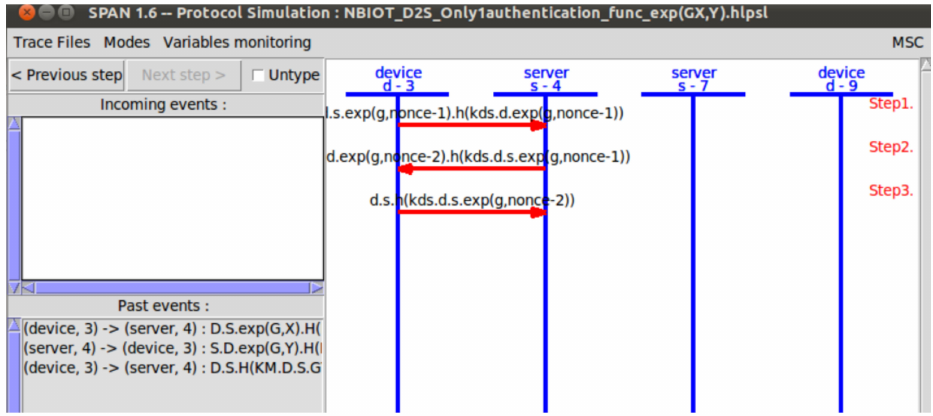
Figure 7. The message sequences of the D2S